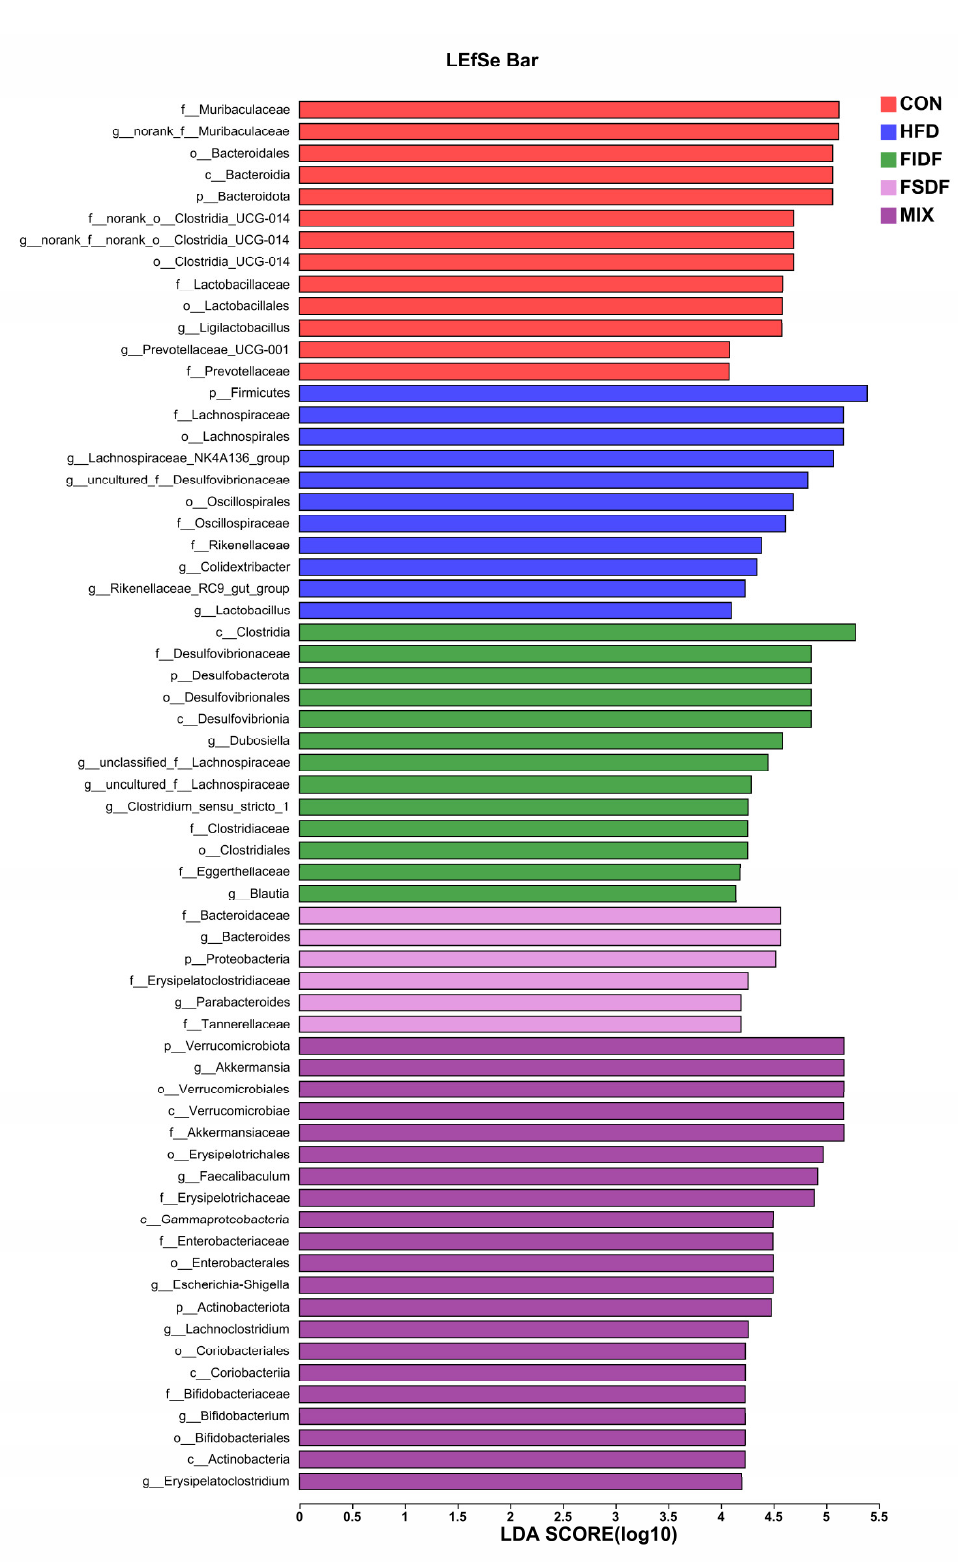
Figure 6. The LEfSe analysis of gut microbiota (LDA scores > 4.0). The characteristic gut microbiota group supplemented with FIDF alone; FSDF, group supplemented with FSDF alone; MIX, group supplemented with FIDF and FSDF